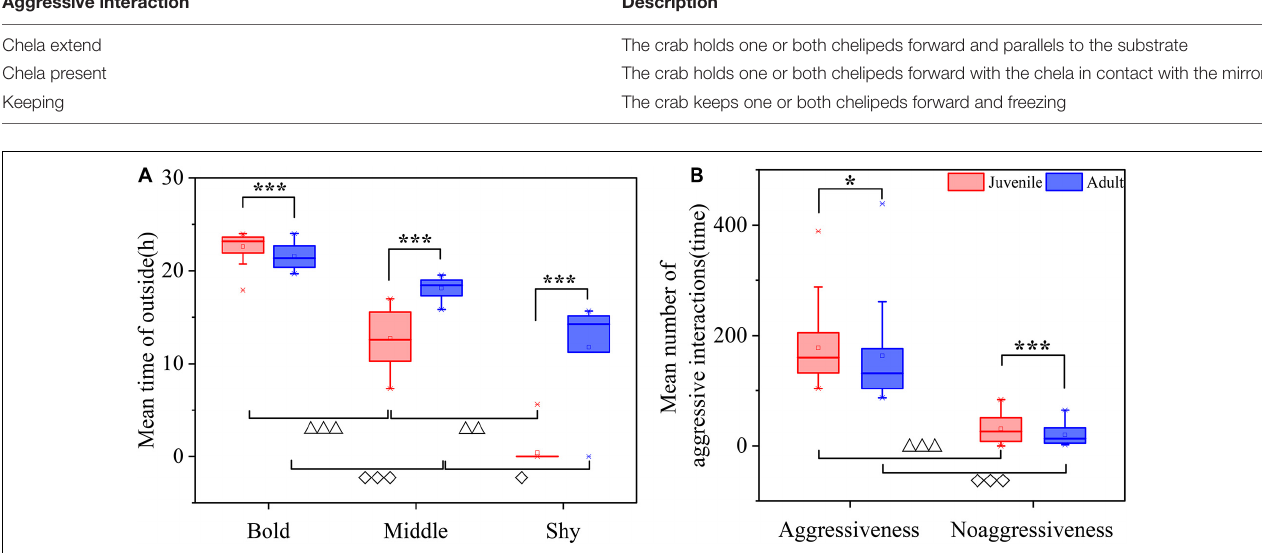
FIGURE 1 | Individual differences between juvenile and adult crabs at different levels. (A) boldness difference. (B) Aggressiveness difference. Asterisk represents that individual difference between juvenile and adult crabs at the same level (“*”: P < 0.05; “***”: P < 0.001). Triangle represents that individual difference between different levels of juvenile crabs (“ (cid:77)(cid:77) ”: P < 0.01; “ (cid:77)(cid:77)(cid:77) ”: P < 0.001). Rhombus represents individual difference between the different levels of personality of adult crabs (“ ♦ ”: P < 0.05; “ ♦♦♦ ”: P < 0.001).